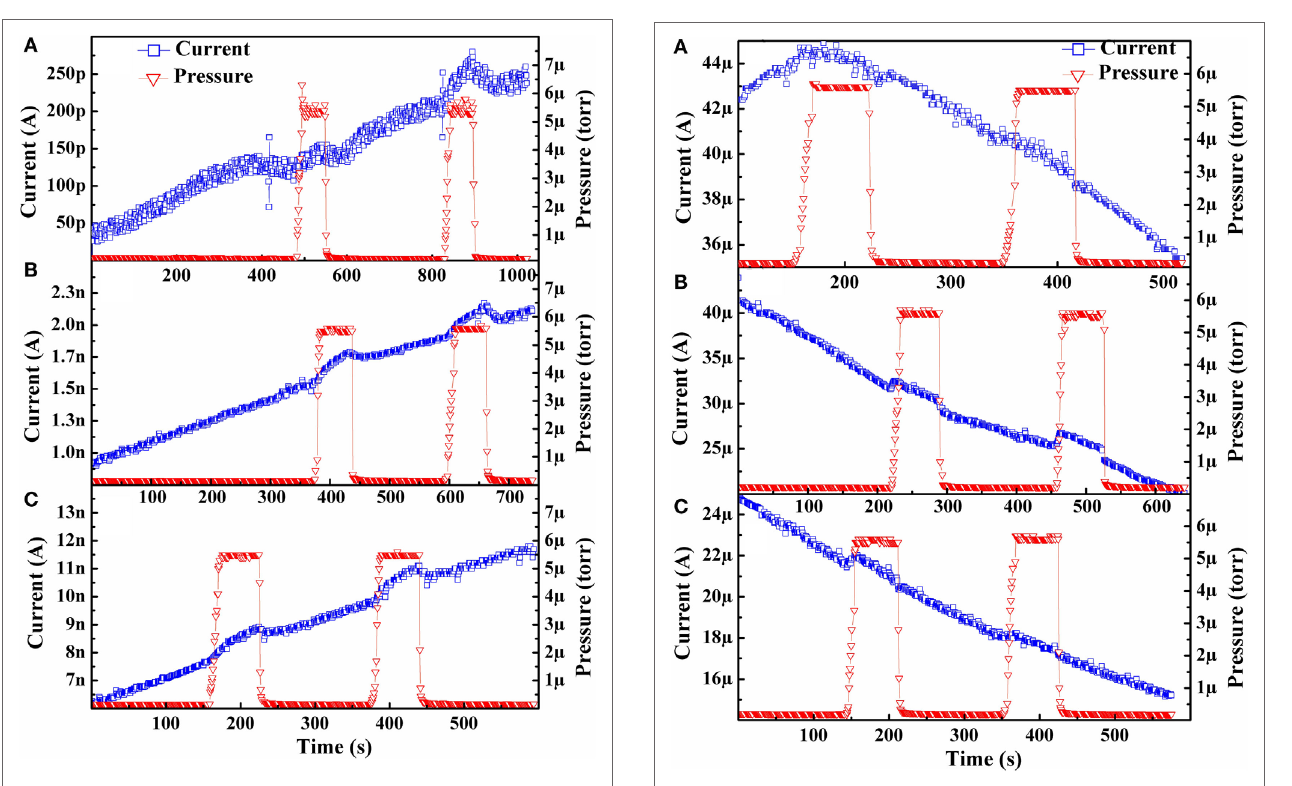
FigUre 2 | Isothermal emission current behavior of a hydrogenated diamond in both vacuum and low-pressure hydrogen environment at: (a) 600°C, (B) 625°C, and (c) 650°C. Only the first testing cycle for the hydrogenated sample is presented for publication purposes as a similar trend was seen for each test in the following two testing cycles. The current and pressure data are represented by blue squares and orange triangles, respectively.